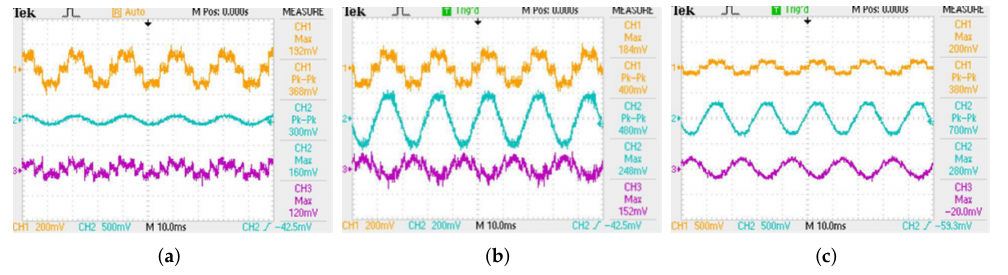
Figure 25. IL, k* irs(ref),and filter current ( a ) at 0.35, ( b ) at 0.85, and ( c ) at